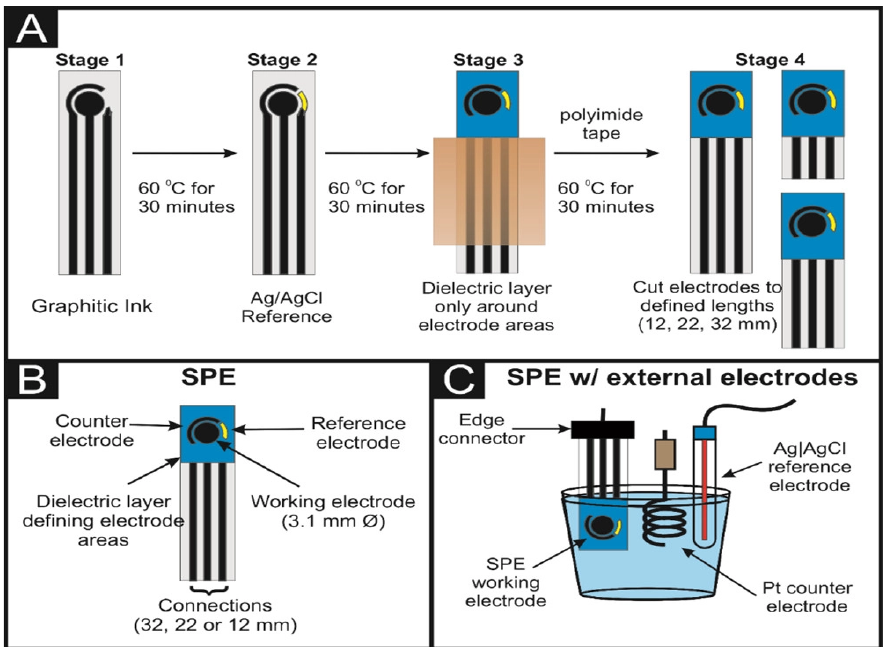
Figure 3. ( A ) Figure showing how to make SPEs using polyimide tape to reduce the amount of dielectric covering and make connection length adjustment simple. ( B ) A diagram depicting a SPE. ( C ) Three-electrode arrangement consisting of a SPE working electrode, Pt wire counter electrode, and Ag/AgCl reference electrode. Reprinted with permission from [67]. Copyright 2021, American Chemical Society.